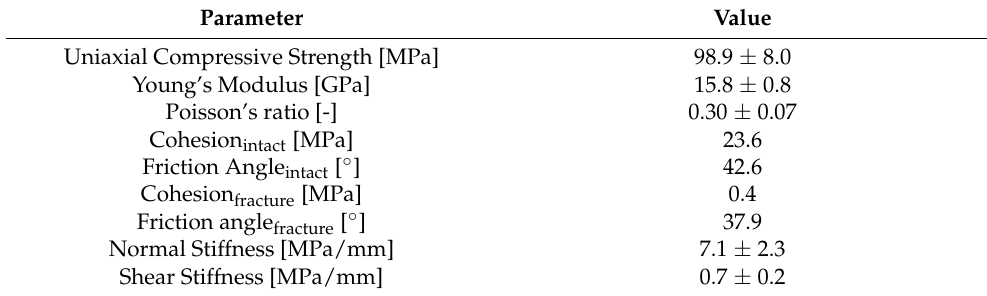
Table 2. Rock mechanical parameters for the Remlingen quarry, including mean and standard deviation